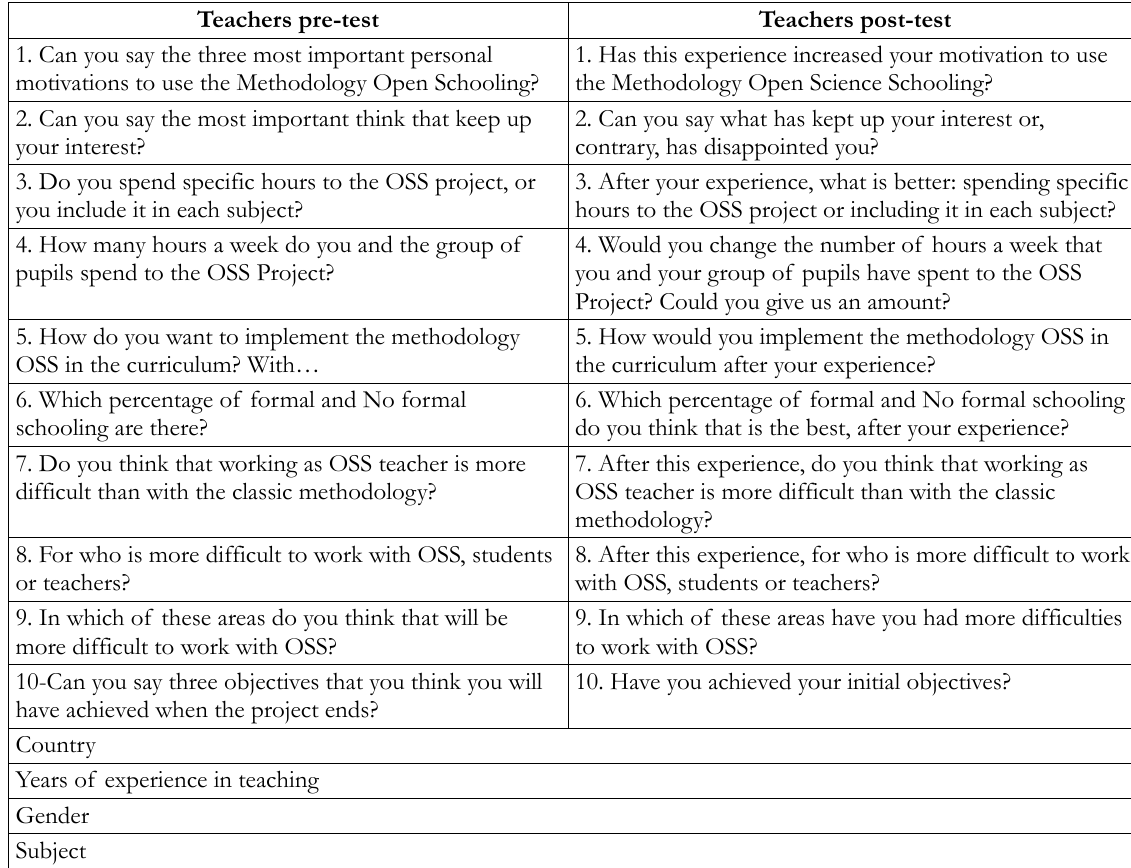
Table 6. Pre-test and post-test questionnaire for